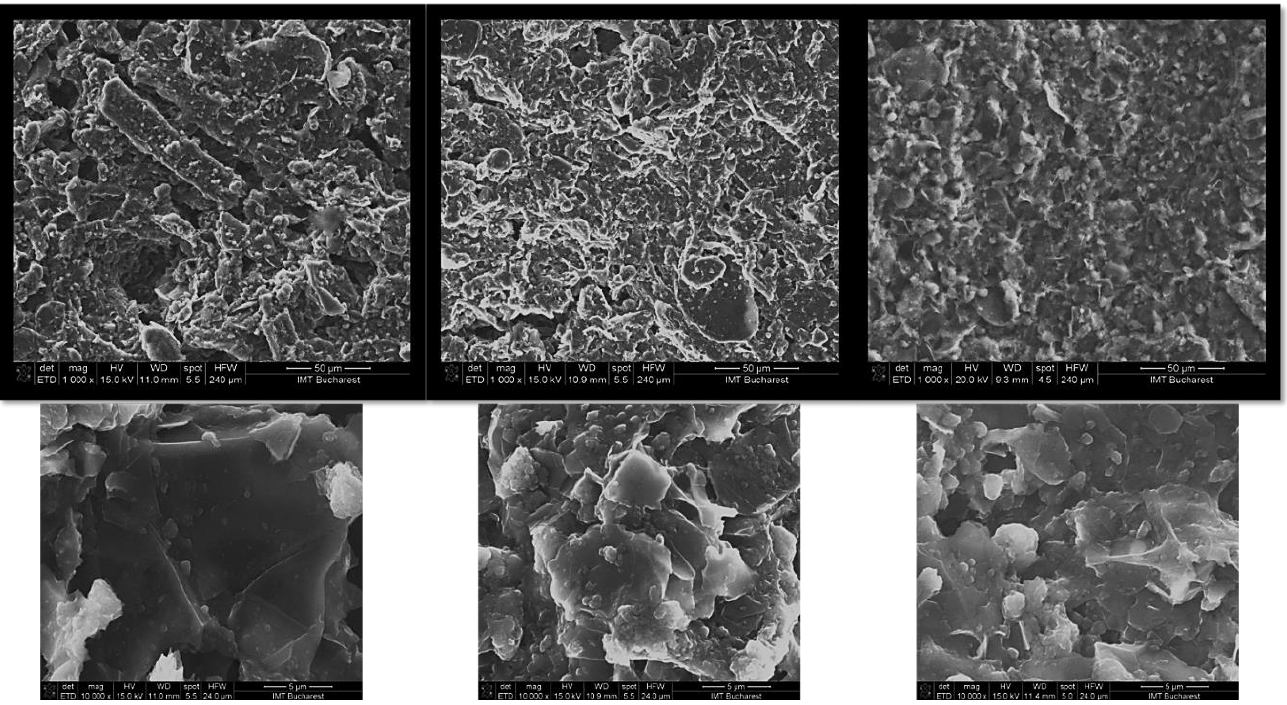
Figure 5. Images of SEM characterization of HCl-doped PANI/graphene/PEDOT:PSS water-based coatings, with one, two, and three layers, at two magnifications (scales of 50 μ m and 5 μ m).